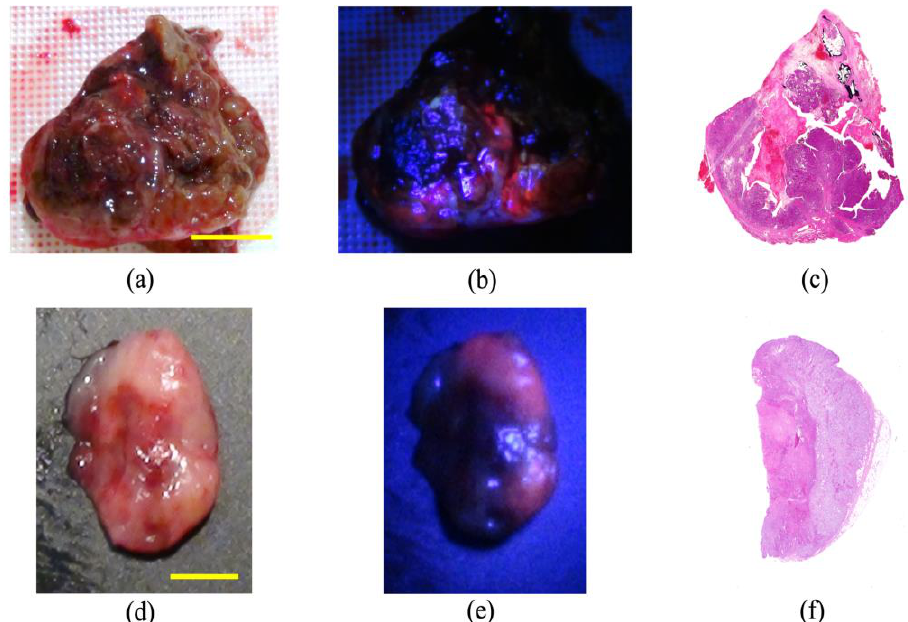
Figure 1. Representative images of photodynamic detection-positive cases. ( a – c ) Canine thyroid carcinoma. The red fluorescence at 635 nm is evident in the cancerous lesions but not in the necrotic tumor lesions. Scale bar: 2 cm. ( d – f ) Inguinal lymph node metastasis in a mammary gland tumor. The red fluorescence at 635 nm is evident in the metastatic lesions but not in the non-metastatic regions. Scale bar: 3 mm. ( a ), ( d ) White light images; ( b ), ( e ) fluorescence light images; ( c ), ( f ) hematoxylin and eosin-stained images.